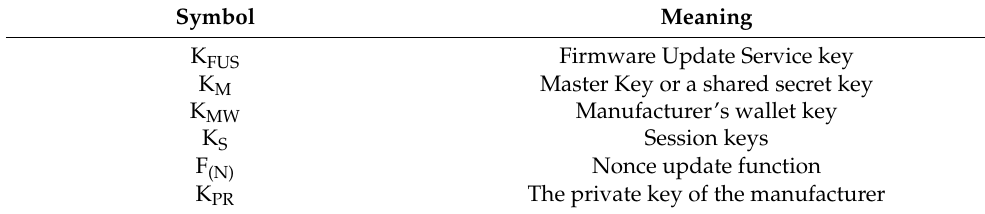
Table 5. Acronyms Used in the Security